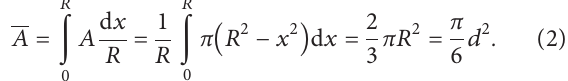
Figure 10: Uniaxial pressure and displacement